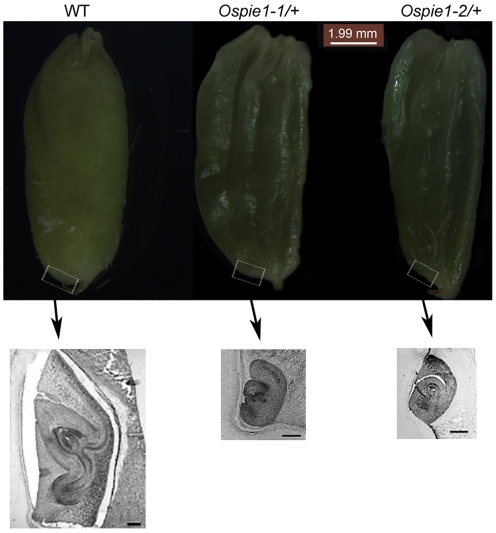
Abnormal embryos in Ospie1 mutants.Upper panels show the representative seeds (with the hull completely removed) in wild-type (WT) and the abnormally developed grains in self-pollinated Ospie1-1/+ and Ospie1-2/+ plants, respectively. The white rectangular box indicates the approximate position of embryo. The bar represents 1.99 mm for all three images in the upper panels. Lower panels show the embryos collected from the seeds indicated in the upper panels, with the bar representing 0.1 mm.